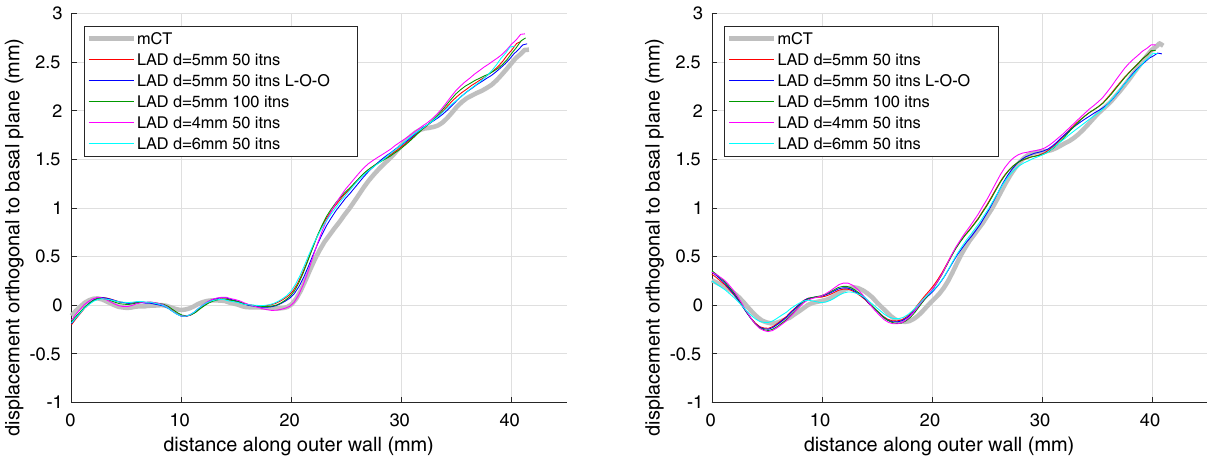
Figure 8. Vertical trajectories of the least (left) and most (right) nonplanar cochleas. The gold-standard micro-CT profiles are displayed in gray. The other profiles are derived from LAD model fits to the standard pseudo-clinical MDCT data thresholded at a grayscale value of 170, with the standard template, an alternative “leave-one-out” (L-O-O) template constructed without the test specimen, different numbers of LAD iterations (itns) and different values of the parameter d